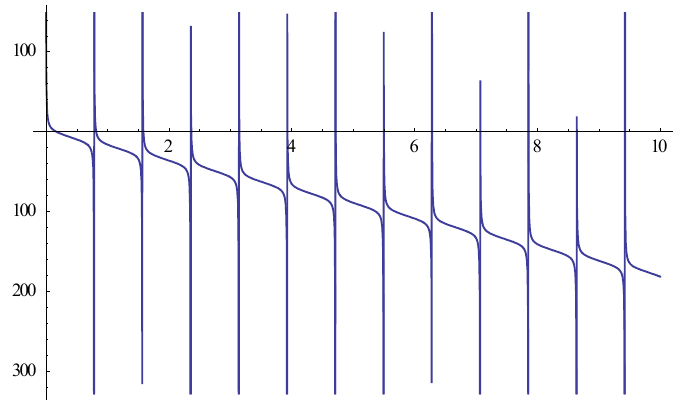
Figure A1. Plot for Eigen Values along the cylinder radius using Equation (A1).